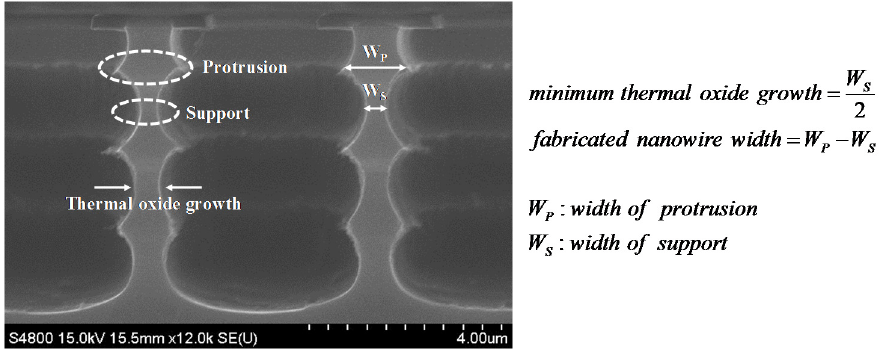
Figure 3. Fabrication result after DRIE, showing silicon protrusions and